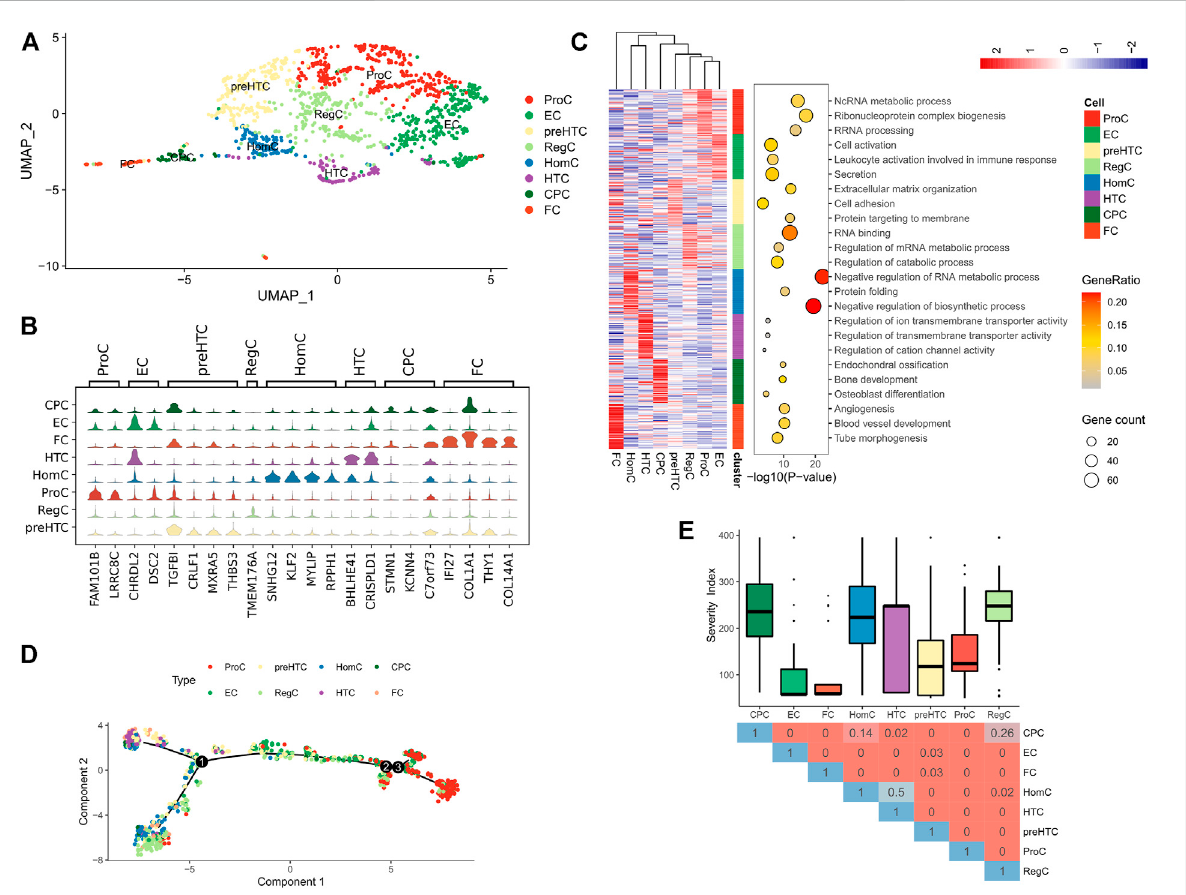
FIGURE 1 Sub-classi fi cation of chondrocytes in OA tissues. (A) UMAP plot of all chondrocytes, which are distinguished by color; (B) Violin plots showing theexpressionofcanonical markergenesofeachchondrocytetype; (C) TheHeatmap(left)oftheexpressionofthetop50differentialgenesineach cell cluster (Z-score normalized) and the representative GO terms (right); (D) Differentiation trajectory of each cell cluster (distinguished by color) in OA tissue; (E) The Box plots showing the Severity score of the 8 cell clusters (upper) and the Heatmap showing the difference represented by p value in Wilcoxon test